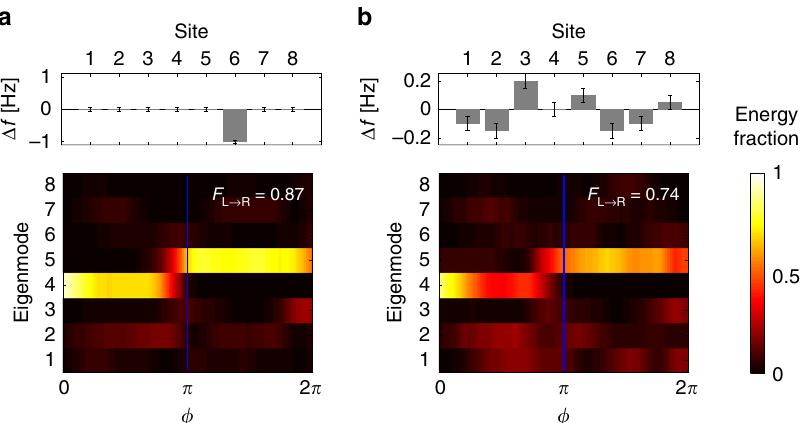
Fig. 4 Pumping in the presence of static on-site potential disorder. a A single resonator is detuned by 1 Hz. b Resonators are randomly detuned by a range spanning ±0.2 Hz from their common frequency, corresponding to ~10% of the band gap. In both cases the temporal heat map of energy fractions shows robust pumping with high transport fi delity. The error bars show the 0.05 Hz frequency uncertainty in the on-site potential disorder due to the measurement